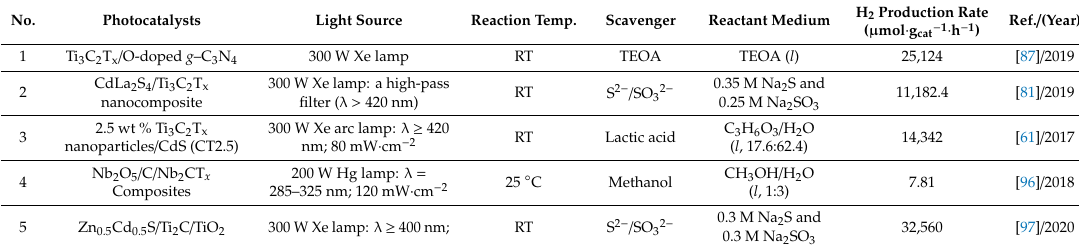
Table 2. Photocatalytic hydrogen production over selected MXenes